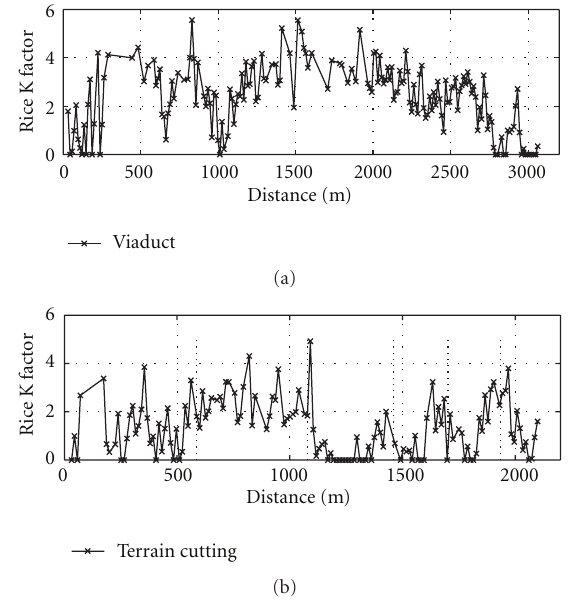
(as a linear power ratio) in both scenarios, including the minimum, maximum, mean, and standard deviation values. Figure 6: Rice K factor as a function of